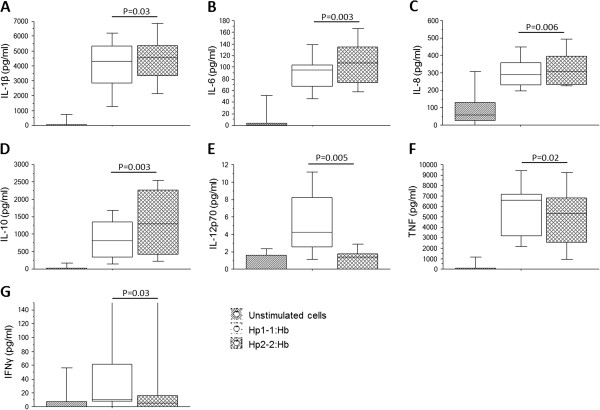
Cytokine profiles in supernatants from in vitro stimulation assays with Haptoglobin:Haemoglobin complexes. Isolated PBMCs were stimulated with Hp1-1:Hb or Hp2-2:Hb (both 10 μg/ml) for 24 hours and thereafter corresponding supernatants were collected and analysed for various cytokines. Levels of A) IL-1beta, B) IL-6, C) IL-8, D) IL-10, E) IL-12p70, F) TNF and G) IFN-γ from 11 independent experiments are shown. The boxes represent the lower quartile (25%) and the upper quartile (75%) with the middle line as the median. The whiskers indicate the 10 and 90% percentiles. Statistical analysis was done with Wilcoxon Signed ranktest.